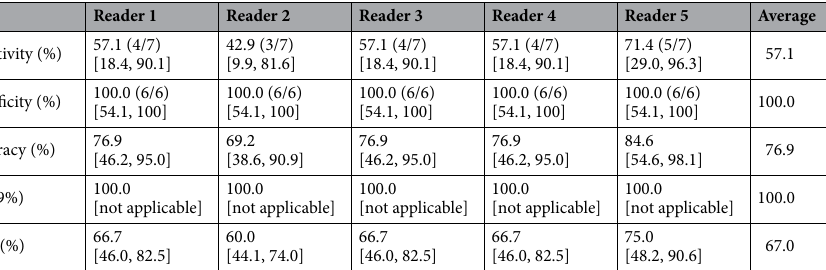
Table 2. Qualitative evaluation based on the T2-FLAIR mismatch sign among the 5 radiologists. NPV negative predictive value, PPV positive predictive value. Data in parentheses are numerators/denominators; data in brackets are 95% confidence intervals.